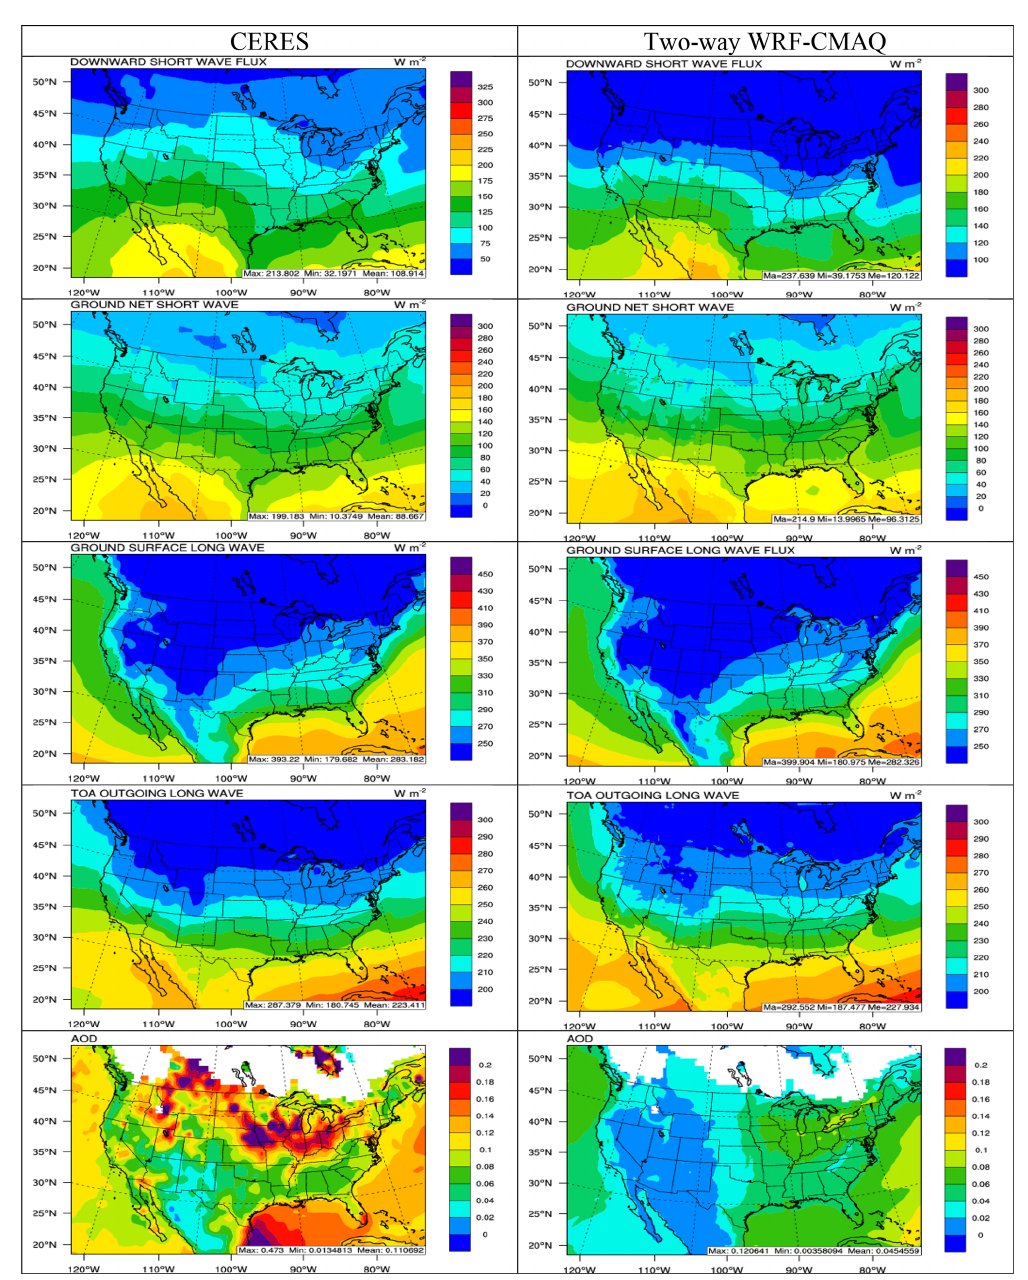
Figure 4. Spatial distribution of 5-year average major radiation variables (from top to bottom: SWDOWN, GSW, GLW, OLR, and AOD) between CERES observations (left column) vs. two-way WRF-CMAQ (right column) in winter